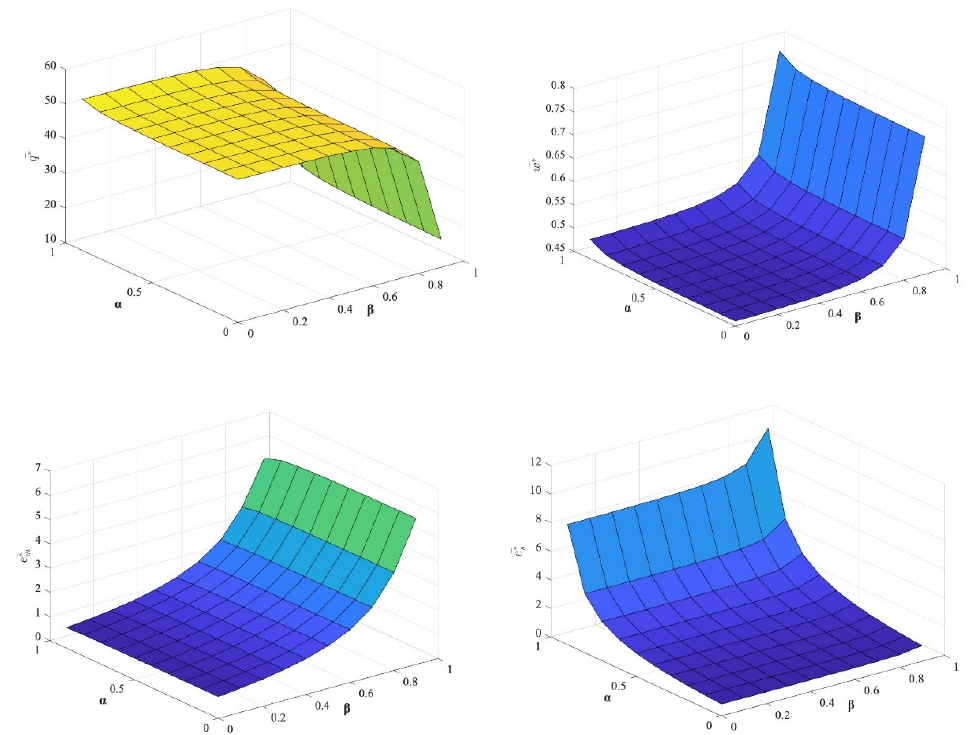
Figure 1. Changes of the equilibrium with two sharing coefficients.